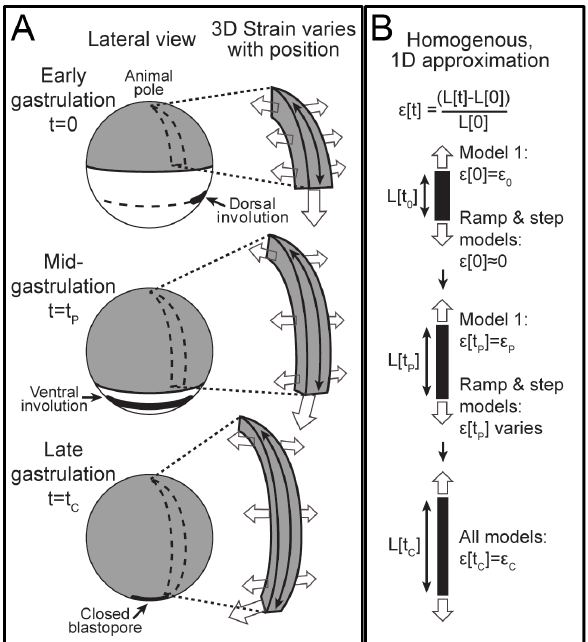
Figure 5. Model schematic. (A) Diagrams of blastopore closure from the lateral side. The ectoderm and neurectoderm (gray) spreads over the embryo during gastrulation. Involution begins on the dorsal side at t=0, and begins on the ventral side at t P ; the blastopore closes at t C . In the generalized model (Model 1) we assumed all morphogenetic durations (t P , t C , etc) changed by the same proportion with temperature. In the step and ramp models (Models 2A & B) t P is used, as an estimate of the timing of cell behaviors that exert morphogenetic forces, to predict t C . A strip of tissue (A, to right of each whole embryo schematic) experiences spatially and temporally varying stresses (open arrows; stresses from deep tissues not shown), which elongate it and change its shape. We approximate this deformation as uniform stretching of a strip of material (B). The generalized model (Model 1) assumes temperature only affects the speed of morphogenesis, therefore each morphogenetic event occurs at fixed, but unspecified strains ( e P , e C ,…). In the step and ramp models (Models 2A & B) the main forces driving blastopore closure begin near the start of ventral involution (so e [0] < 0), and blastopore closure occurs at a fixed strain ( e [t C ]= e C ); however, the strain at t P varies with temperature.